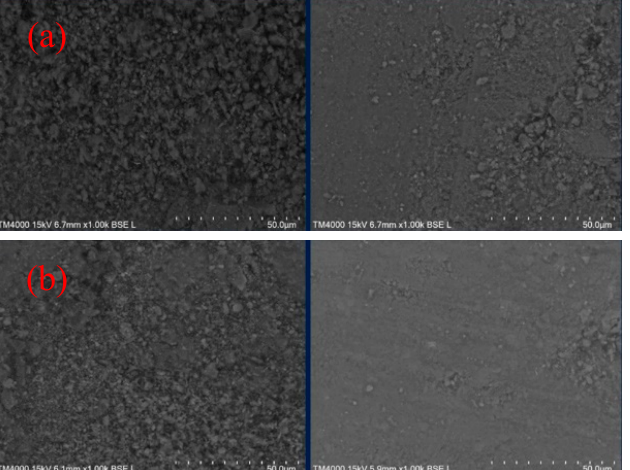
end; ( b ) 0.5 m below pile